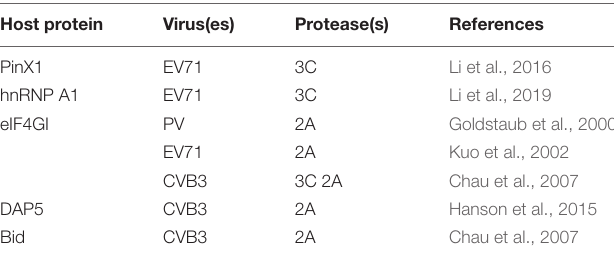
TABLE 2 | Host proteins cleaved by enterovirus protease(s) during induction of